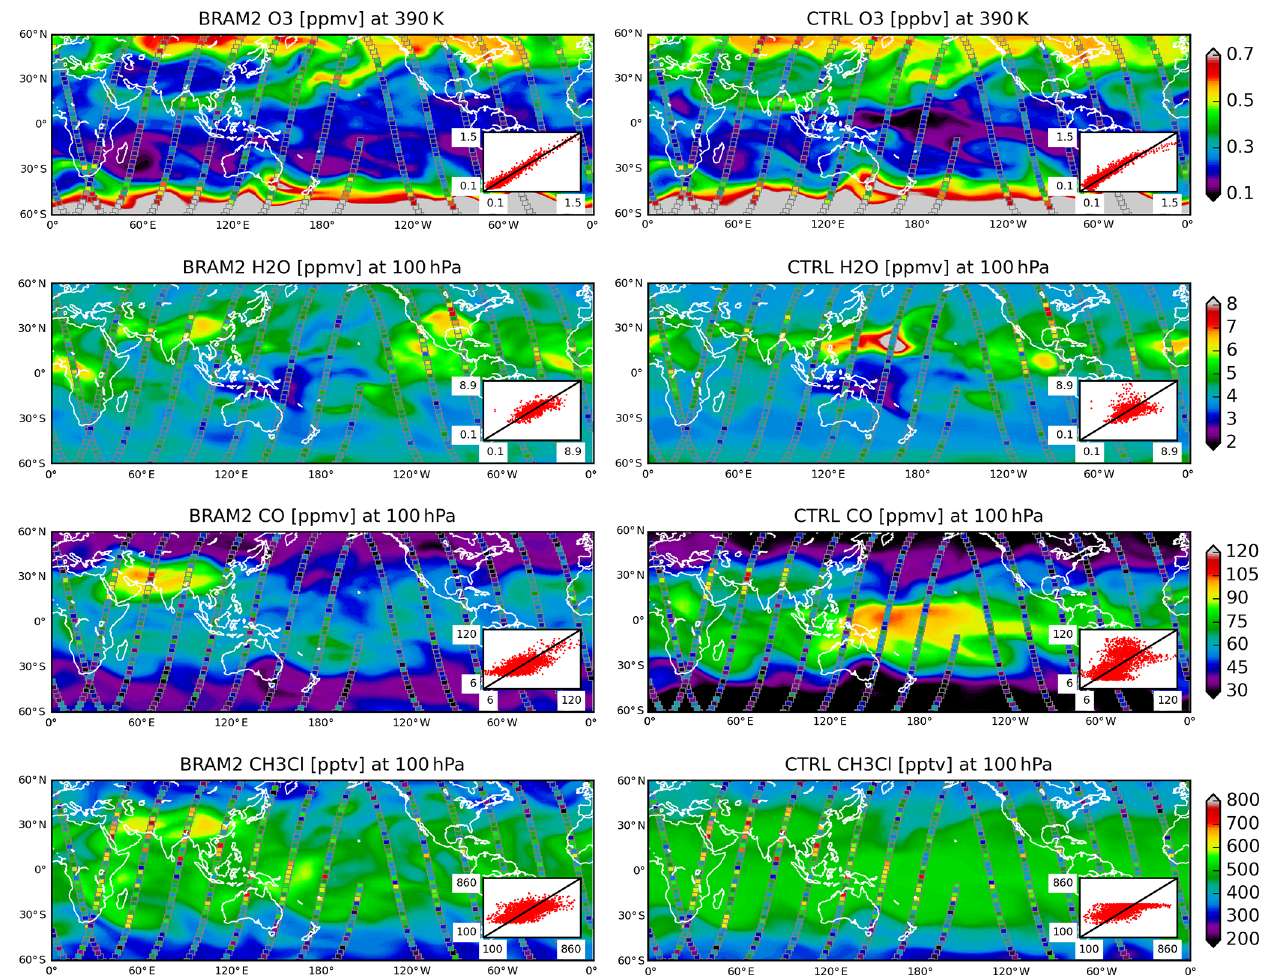
Figure 11. The filled contour maps (between 60 ◦ S and 60 ◦ N) show the BRAM2 (left column) and CTRL (right column) distribution of, from top to bottom, O 3 , H 2 O, CO and CH 3 Cl on 14 July 2009 at 12:00UT at 390K (O 3 ) or 100hPa (H 2 O, CO and CH 3 Cl). Coloured squares correspond to the MLS values between 06:00 and 18:00UT on that date at the same levels. To improve the readability, only one in two MLS observations is shown. Scatter plots in the lower right corner of each map show the correlation between MLS and BASCOE (BRAM2 or CTRL, MLS on the x axis, BASCOE on the y axis) where all MLS data for that day are used, where BASCOE values are taken from the ModAtObs files (see Sect. 3.4) and where the black lines show the perfect